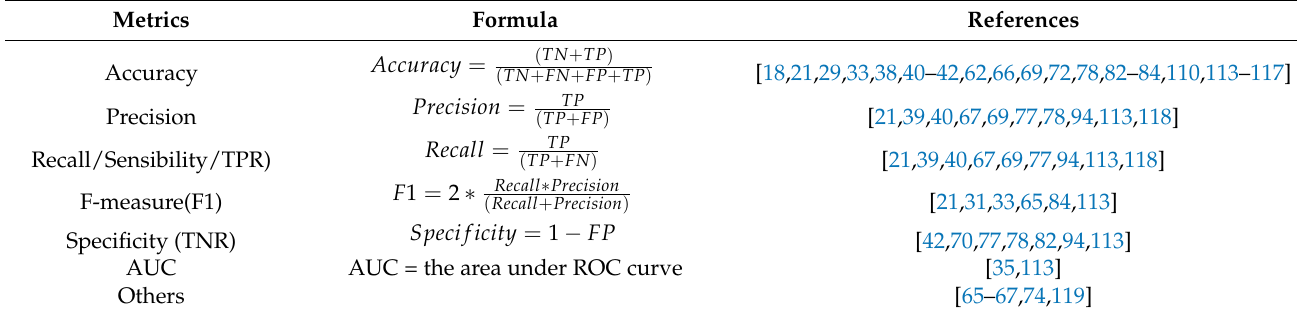
Table 7. Performance evaluation